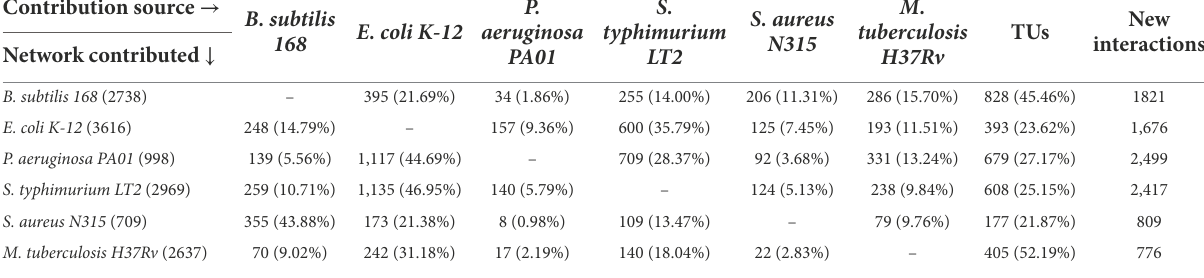
TABLE 1 Total new interactions per